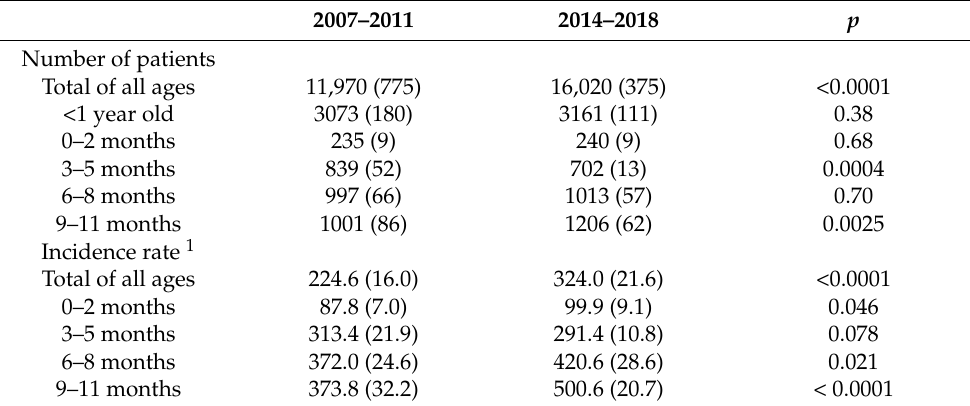
Table 4. The number of KD patients and incidence of KD by age group for the 5-year periods before and after 2012–2013 according to the Nationwide Survey of